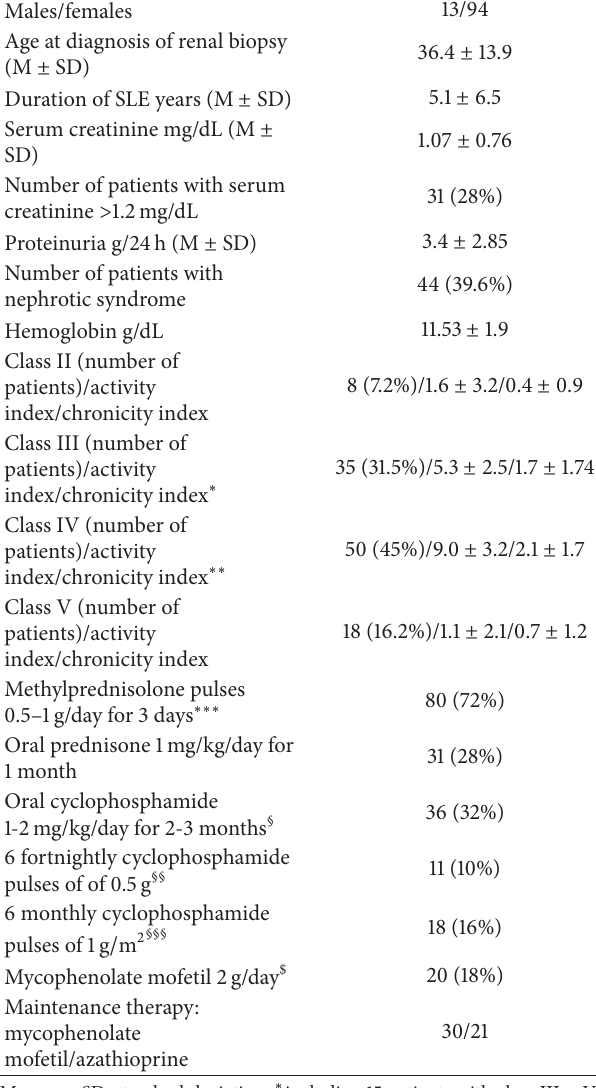
Table 1: Clinical and histological characteristics at renal biopsy of the 107 lupus nephritis patients enrolled in the study who received 111 renal